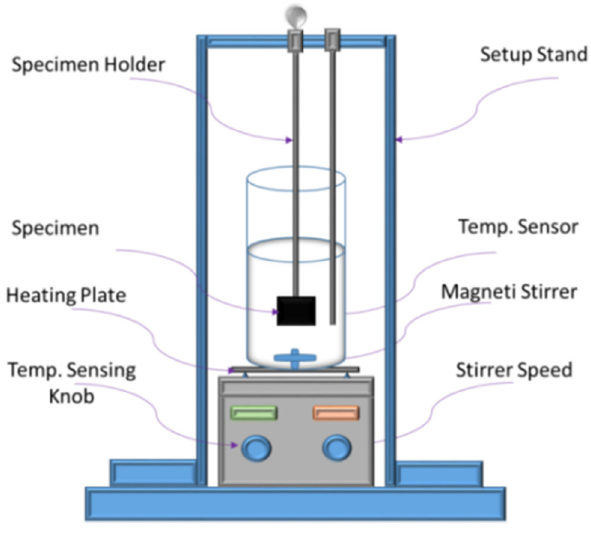
Figure 2: The apparatus of the electroless coating process.